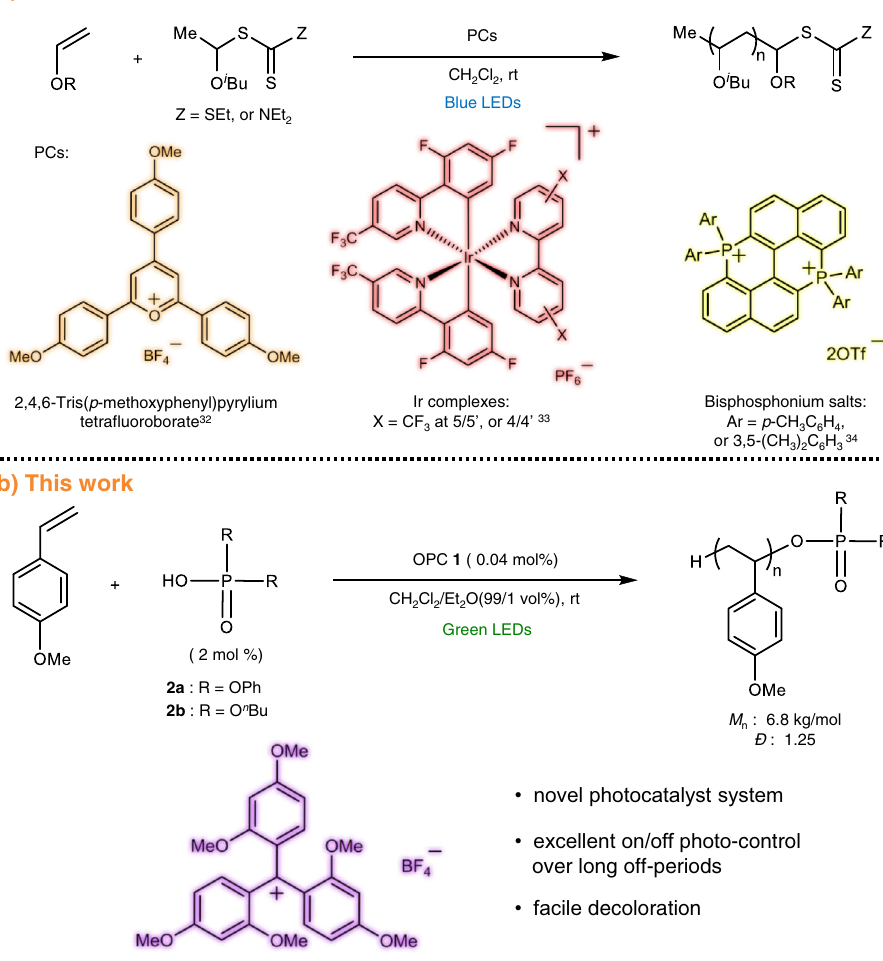
Fig. 1 Recent reported in visible light driven photo-controlled living cationic polymerization. a Photocatalysts (PCs) and CTA employed in previous work. b The novel visible light-driven photo-controlled living cationic polymerization system in this